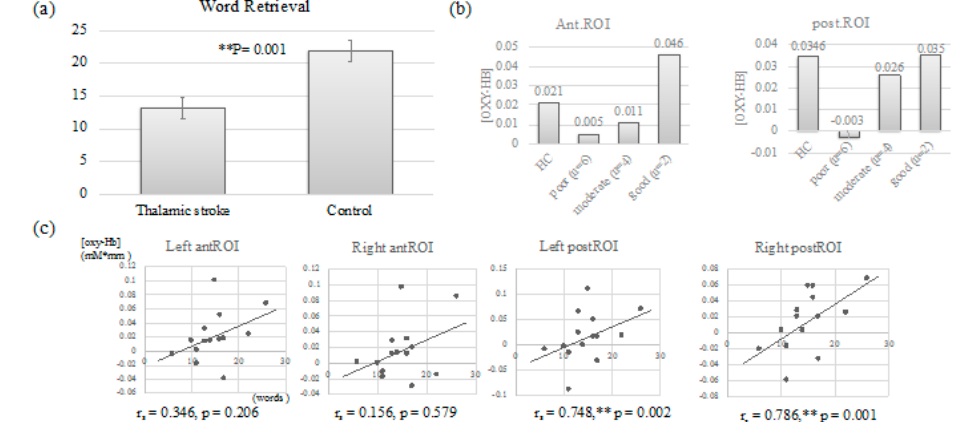
Figure 4. ( a ) Verbal fluency task (VFT) performance during NIRS sessions: comparison between thalamic stroke survivors and age-matched control subjects. Note significant word retrieval decline in the patients relative to the control group. ( b ) When patients were classified into three groups by severity of word retrieval decline, the poor and moderate groups showed remarkably low SMA responses relative to those in the healthy group. ( c ) Association of [oxy-Hb] at each region of interest (ROI) with VFT performance during NIRS. In particular, [oxy-Hb] at left and right posterior ROIs had strong correlation with word retrieval ability. ** p <